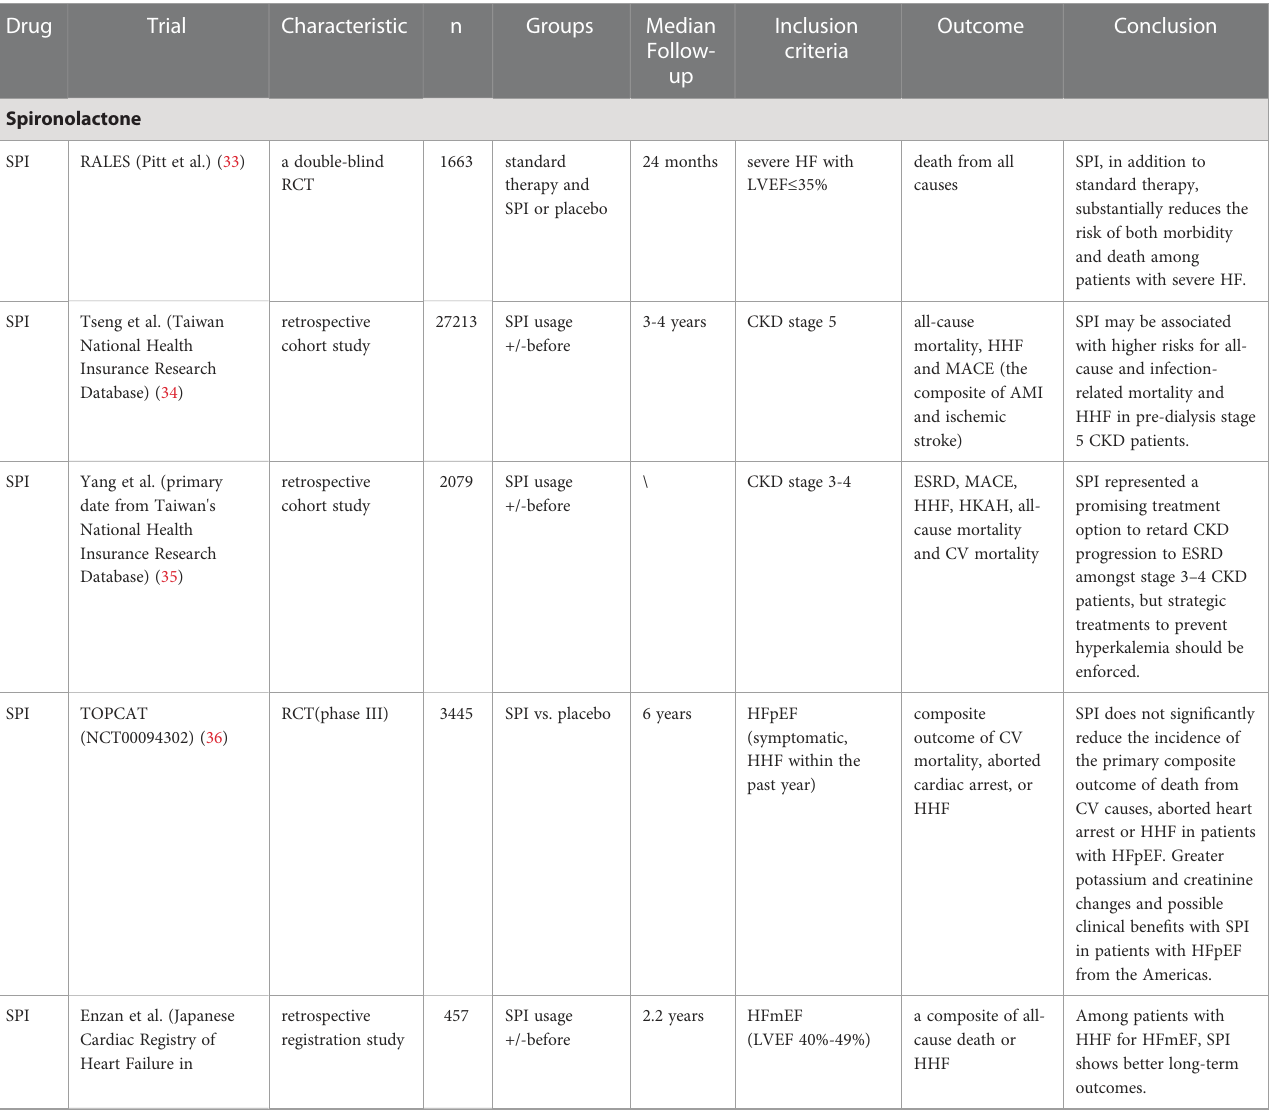
TABLE 2 The Trials Information of